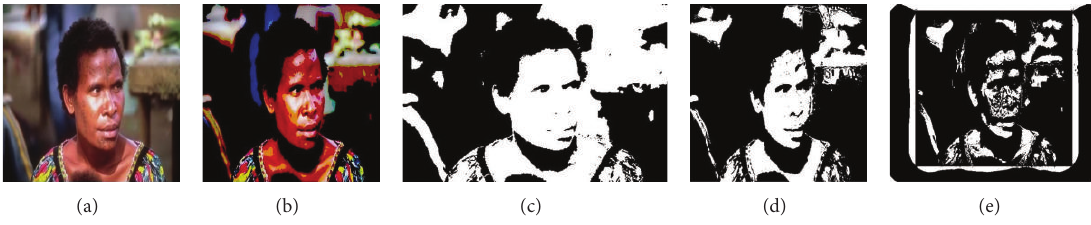
Figure 6: (a) Original image, (b) image of bit plane 8, (c) binarization of original image using mean threshold, (d) binarization of bit plane 8 with mean threshold, and (e) binarization of bit plane 8 with Niblack’s method of local